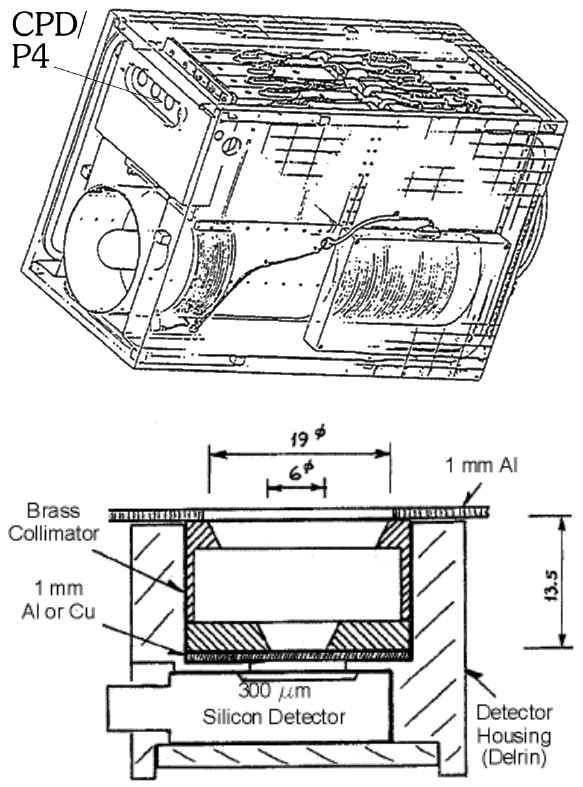
Fig. 2. (a) Oersted main body with stowed boom and the CPD, (b) P3 and P4 detector assembly.